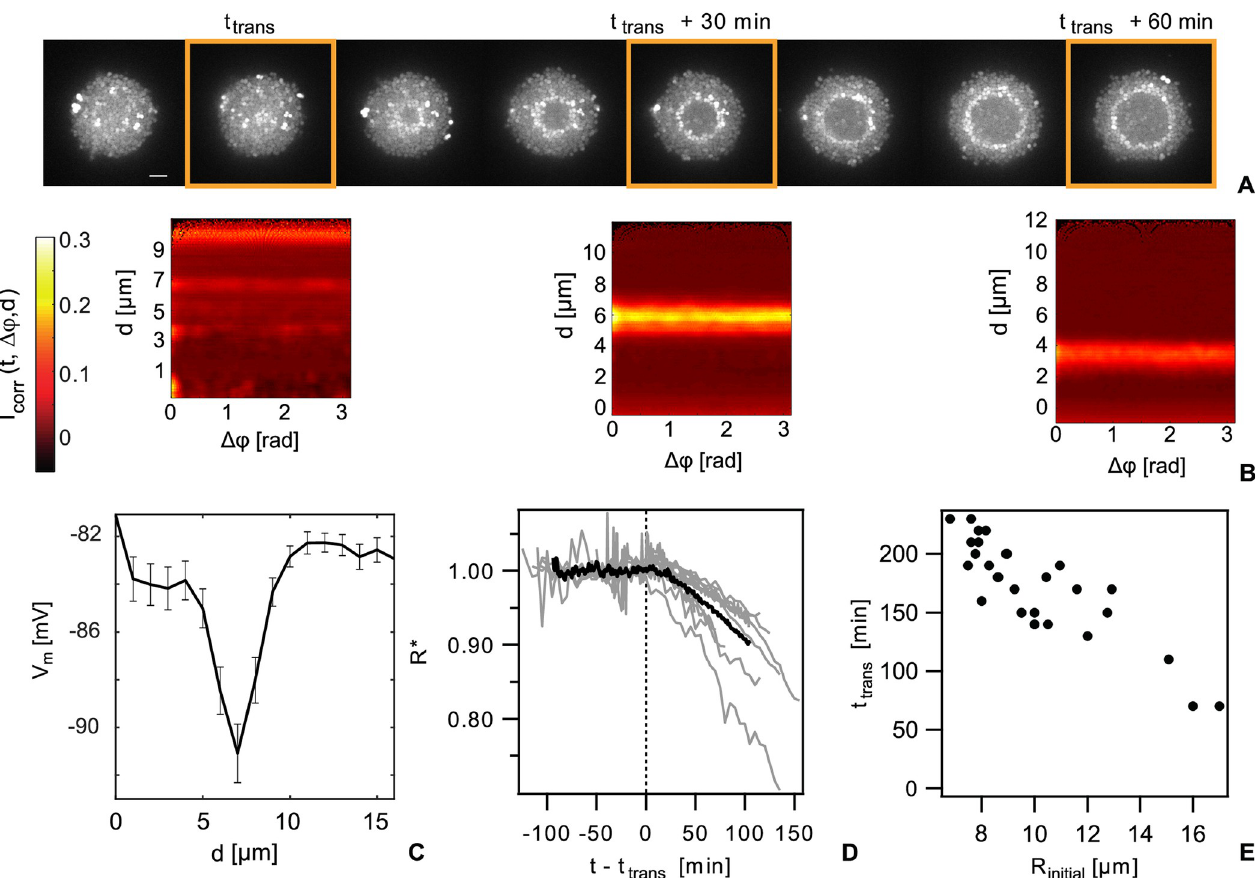
Fig 2. Traveling shell of hyperpolarized cells in large colonies. Strain wt green strain (NG194). t transitions to collective behavior. (A) Typical time lapse of TMRM fluorescence in flow cell, beginning 3 h after incubation. Scale bar: 5 μ m. (B) Angular correlation of the intensity fluctuations as a function of radial position within the colony I to the fluorescence images in (A) at the time points indicated by orange frames. (C) Radial membrane potential of cells in colonies at the time point where the hyperpolarized cells reside 7 μ m from the edge of the colony ( d : distance from the edge of the colony). (D) Colony radius R ( t ) normalized to an exponential � � l 0 t function R � t ð Þ ¼ R ð t Þ = R . The time axis was shifted to set t = 0 at the time when collective hyperpolarization occurs in the TMRM image. λ 0 : initial 3 0 e growth rate, R 0 : initial colony radius. Deviation from 1 indicates deviation from exponential growth. Black line: mean of 10 colonies from 3 different measurement days. Gray lines: individual colonies. (E) Time point of the transition to collective behavior as a function of initial colony size in static cultures (see S1 Data for raw